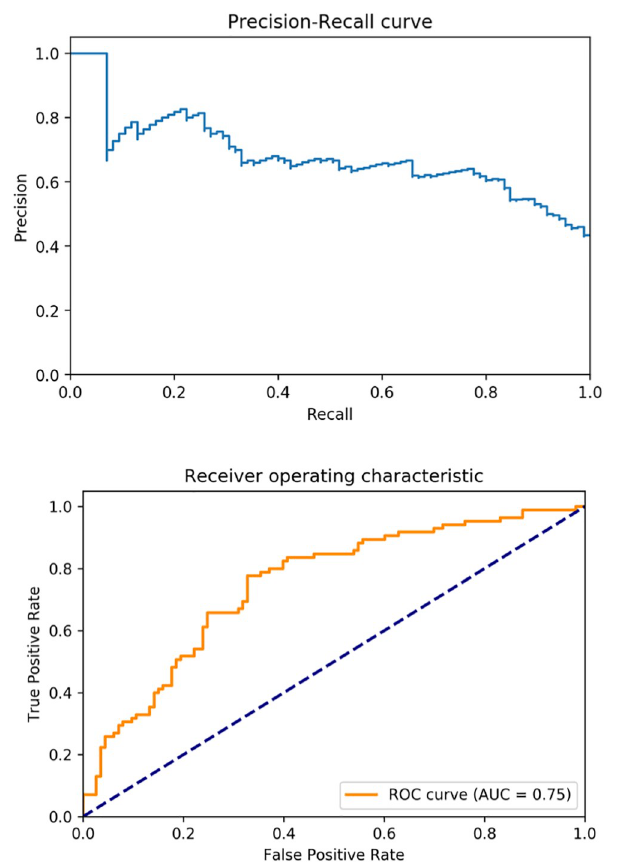
Fig 2. Precision-recall curve and ROC curve of the final